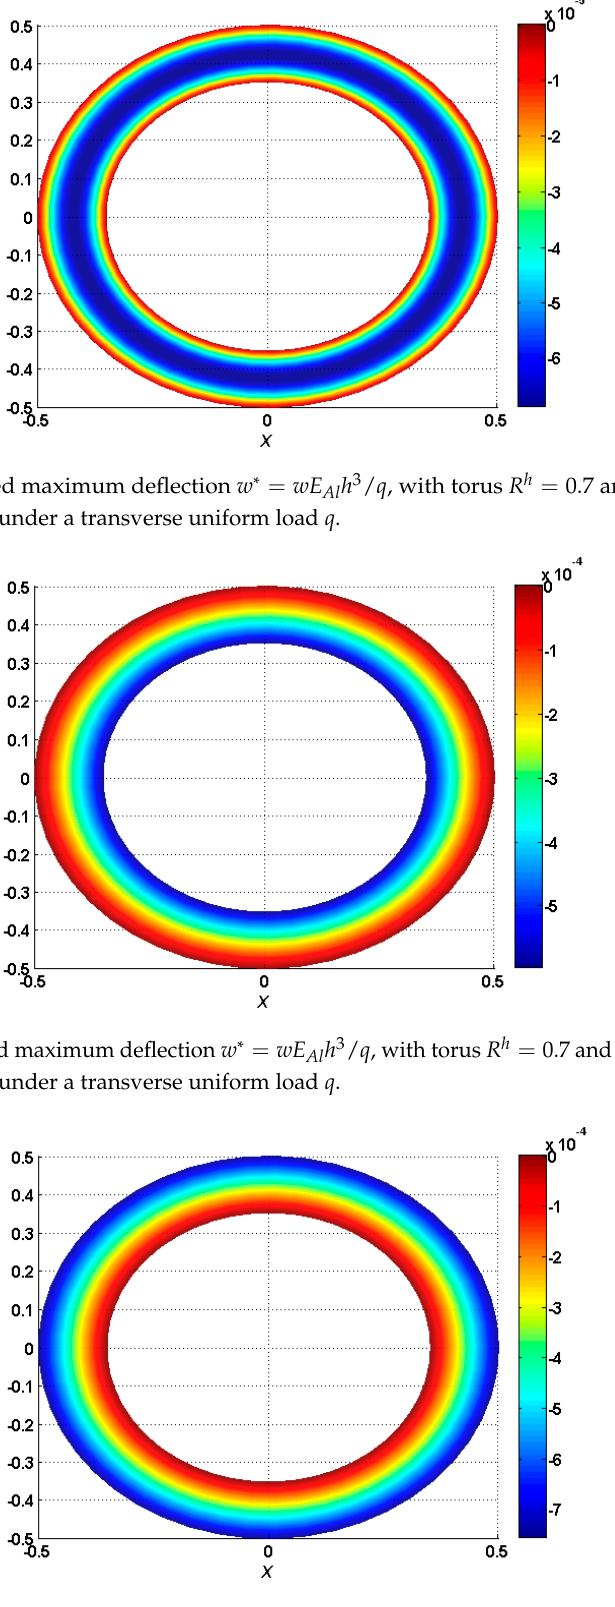
Figure 13. Normalized maximum deflection w ∗ = wE Al h 3 / q , with torus R h = 0.7 and internal clamped boundary conditions under a transverse uniform load q .